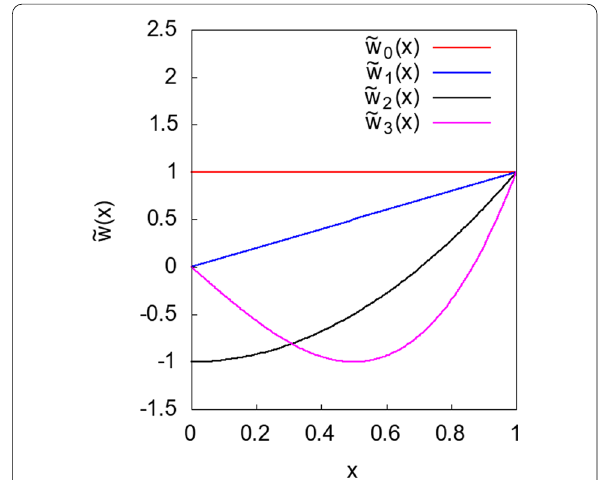
Fig. 11 Mode shapes for a beam with free ends